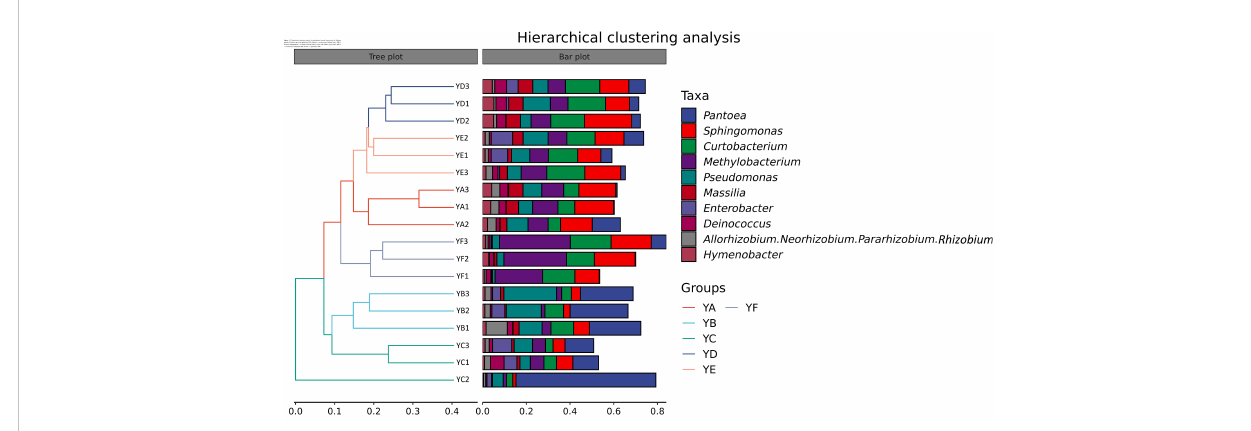
FIGURE 3 Hierarchical clustering analysis of phyllosphere bacterial communities of different species of Populus spp. at the genus level. YA: Populus x euramaricana 'Bofeng 3 hao'; YB: P. deltoides 'Shanghaiguan' P. deltides 'Harvard'; YC: P. nigra 'N46'; YD: P. nigra 'N102' ; YE: P. x euramericana 'Guariento'; YF: P. alba × P. glandulosa '84k'.